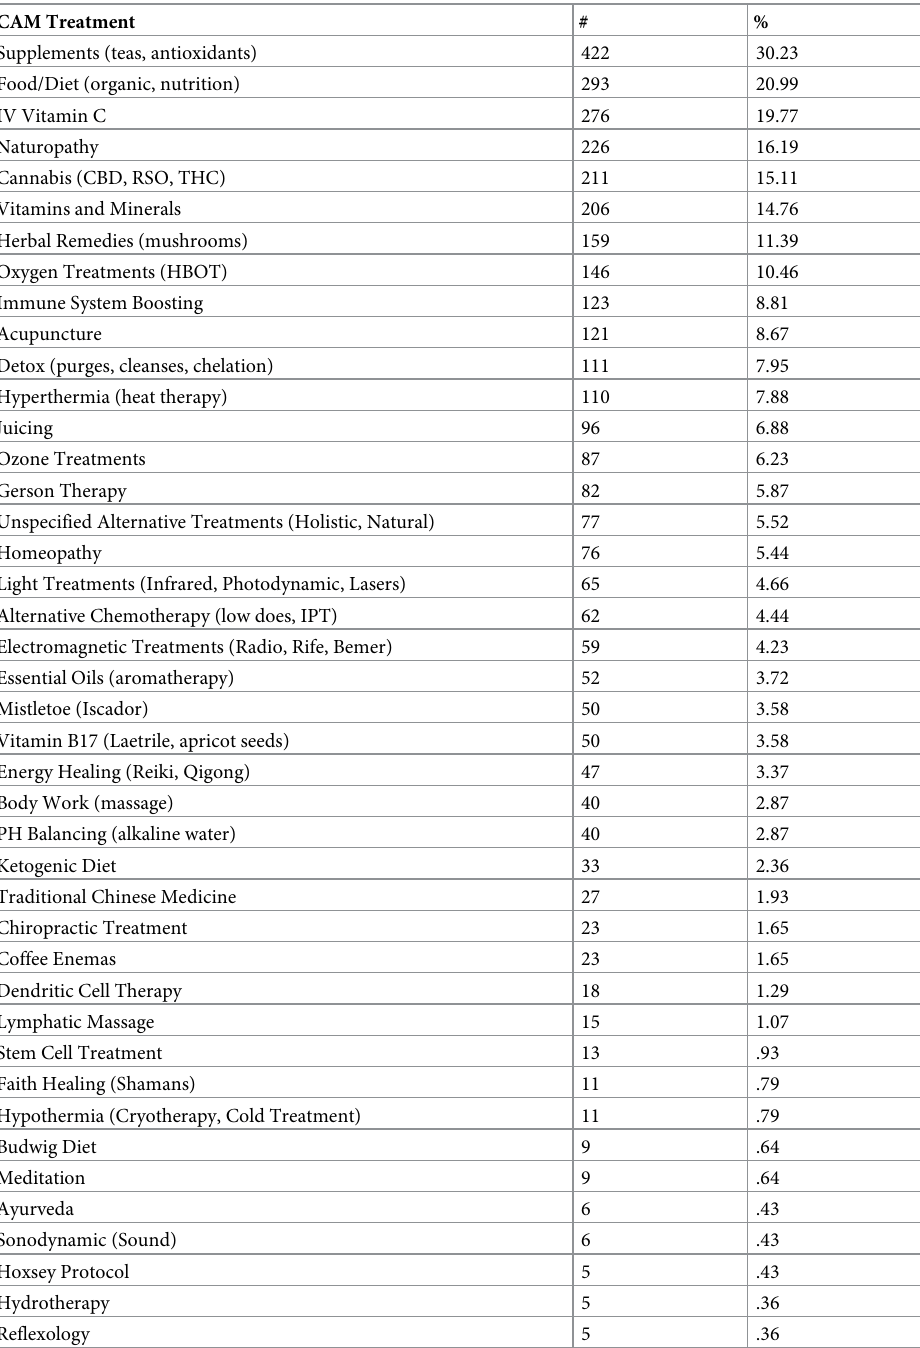
Table 5. CAM treatment